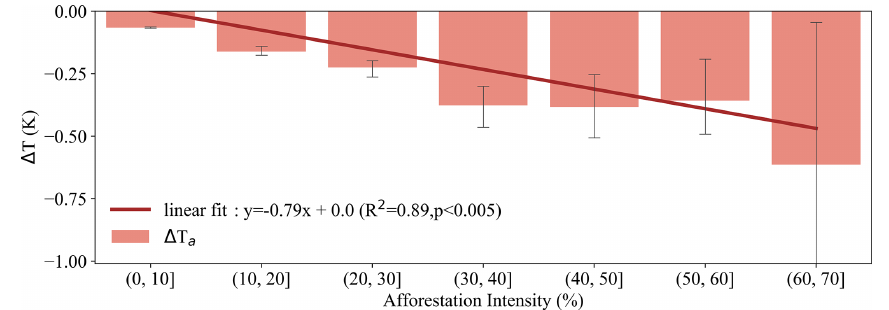
Figure 5. Changes in (cid:49)T a as a function of afforestation intensity ( F aff ), defined as the fraction of afforested area to the total pixel area at a 1km resolution. Error bars indicate the standard error of (cid:49)T a within each 10% bin of F aff . The red line represents the fitted linear regression line between (cid:49)T a and F aff